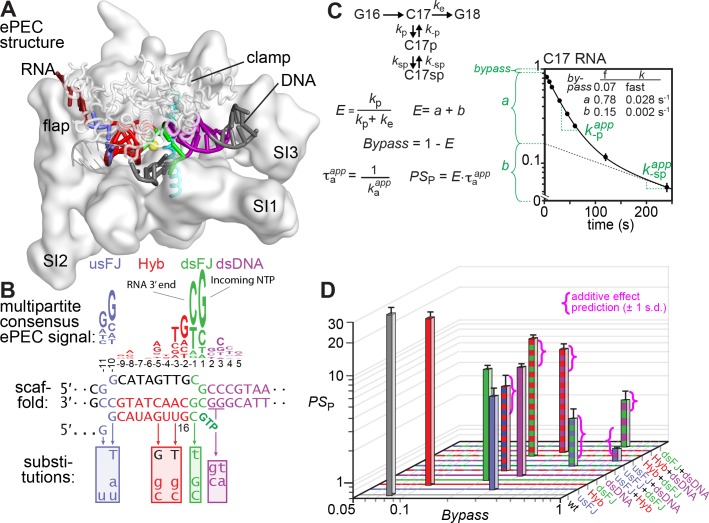
The elemental pause signal is multipartite.(A,B) The consensus ePEC. The ePEC structure (pdb 6bjs; Kang et al., 2018a) is shown above the consensus pause sequence (Larson et al., 2014) color-coded as usFJ (blue), Hyb (red), dsFJ (green), and dsDNA (purple). Scaffold substitutions tested for effects on pausing are shown below the location of the changes. (C) Two-component pause mechanism, equations used to calculate pause efficiencies and pause strengths, and example plot of pause assay data. The pause assay data shown are for the ‘wild-type’ (unsubstituted) consensus pause scaffold at 37°C and 10 µM GTP. Pause fractions (fast fraction a, slow fraction b) and escape rates k-p,app and k-sp,app were obtained by nonlinear regression using a double-exponential equation (see Materials and methods). (D) Plot of pause strength (PSP) vs. bypass for each scaffold variant. Combinations are indicated by ‘+” (e.g., usFJ + Hyb). The magenta brackets show the predicted range of PSP values (95% confidence interval) for combinations of substitutions in individual pause signal elements assuming the pause signal elements additively and independently affect a single energy barrier to pause escape (additive effects on ∆G‡ are multiplicative in PSP). Additional data for the wild-type and mutant pause signals are in Figure 2—figure supplement 1.10.7554/eLife.40981.009Figure 2—source data 1.Fraction C17 pause RNA for wild-type and mutant pause signals.